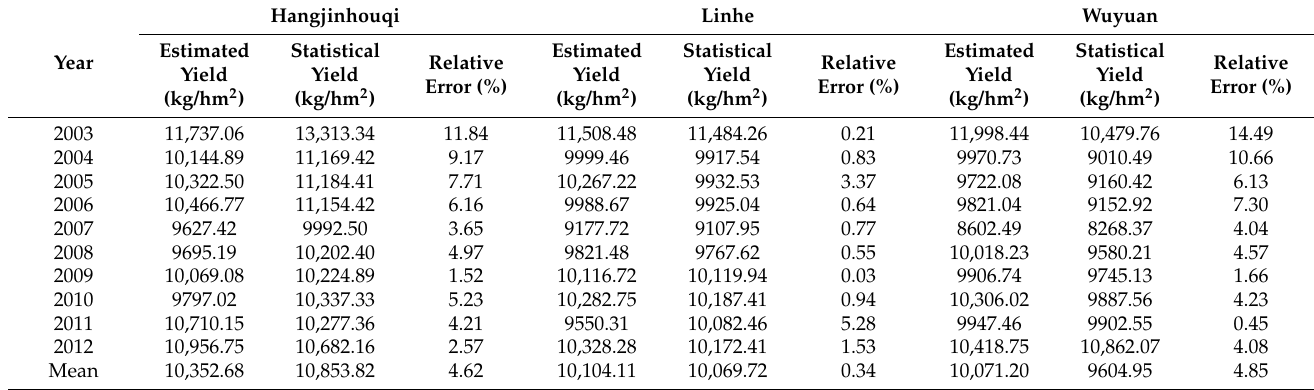
Table 2. Comparison of estimated and statistical maize yields in three counties from 2003 to